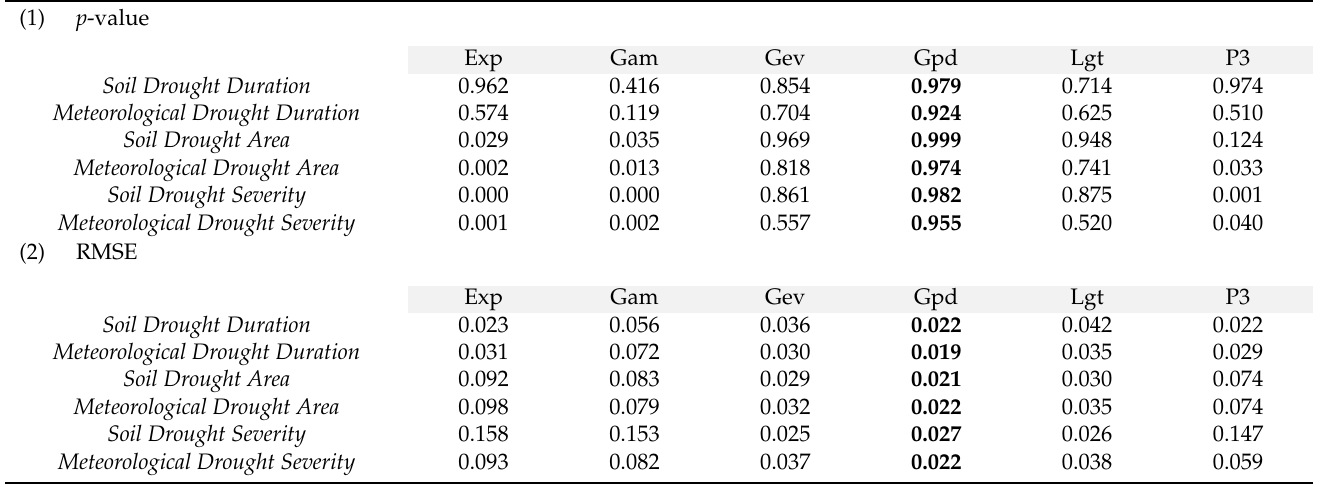
Table 1. The goodness of fits in the distributions of drought parameters.